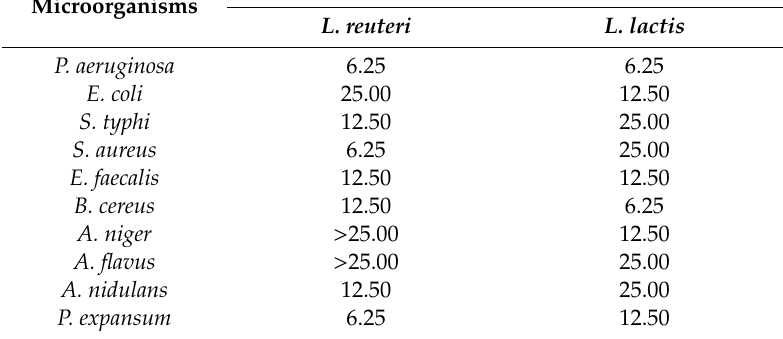
Table 3. Minimum inhibitory concentrations of the LAB cell-free supernatant against tested microbial strains.